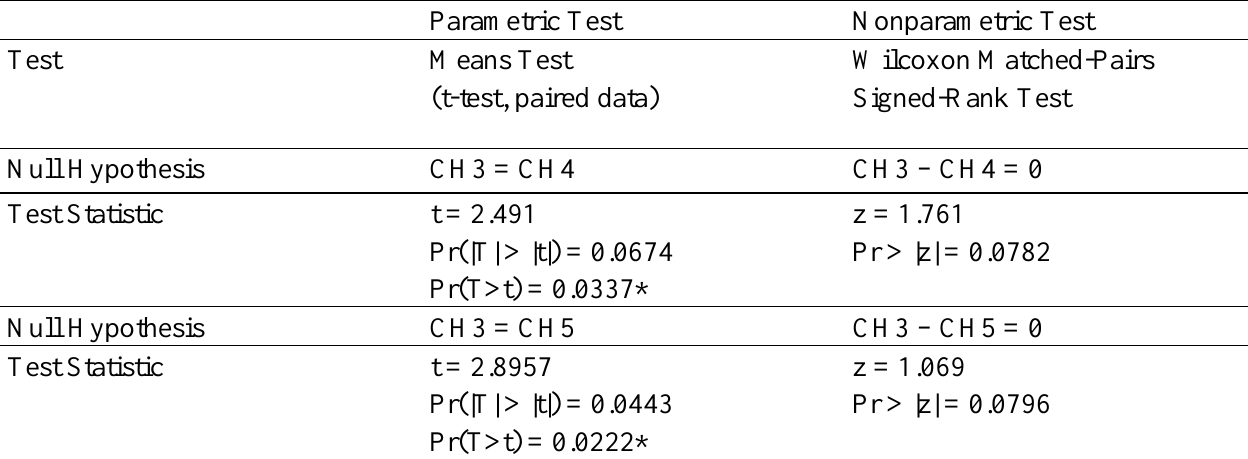
Table A8. Parametric and nonparametric tests of avg. Type Y data for CH3, CH4, and